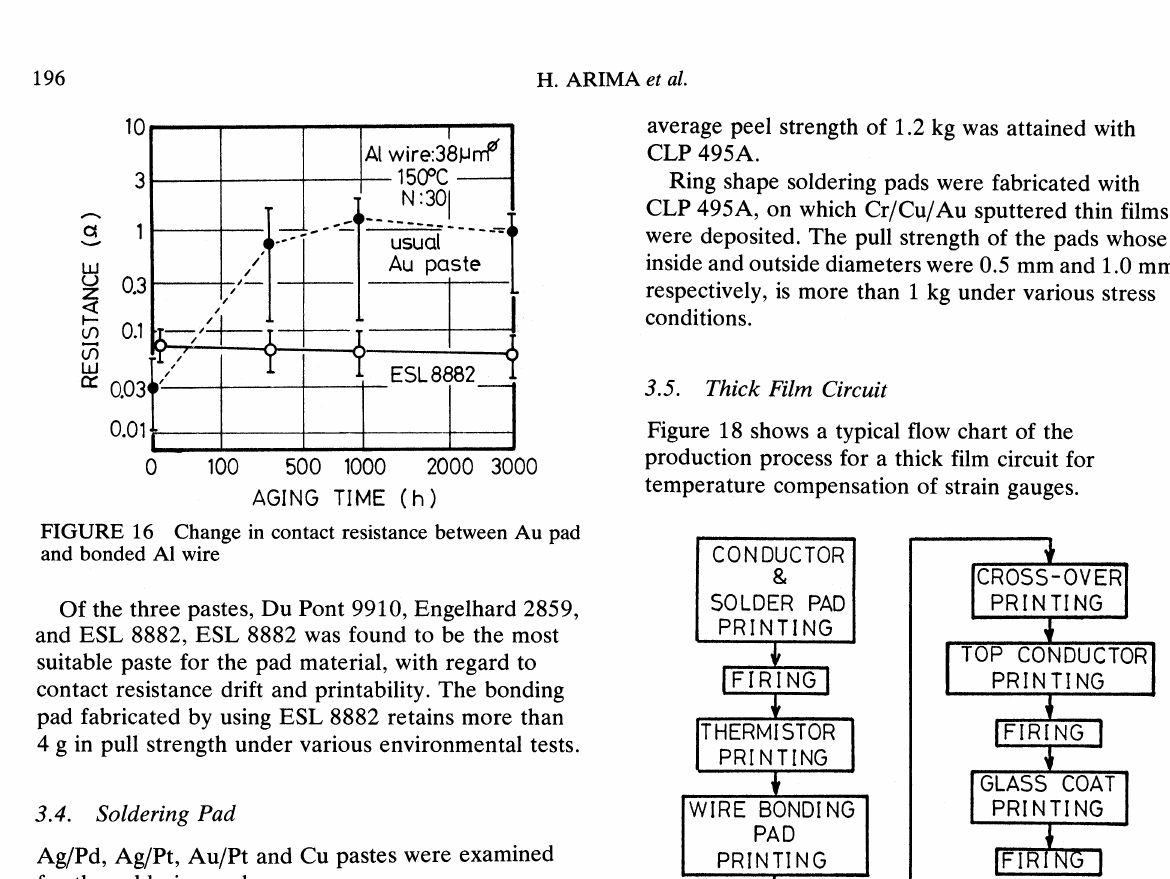
FIGURE 18 Typical production process of thick film circuit for temperature compensation of strain gauges